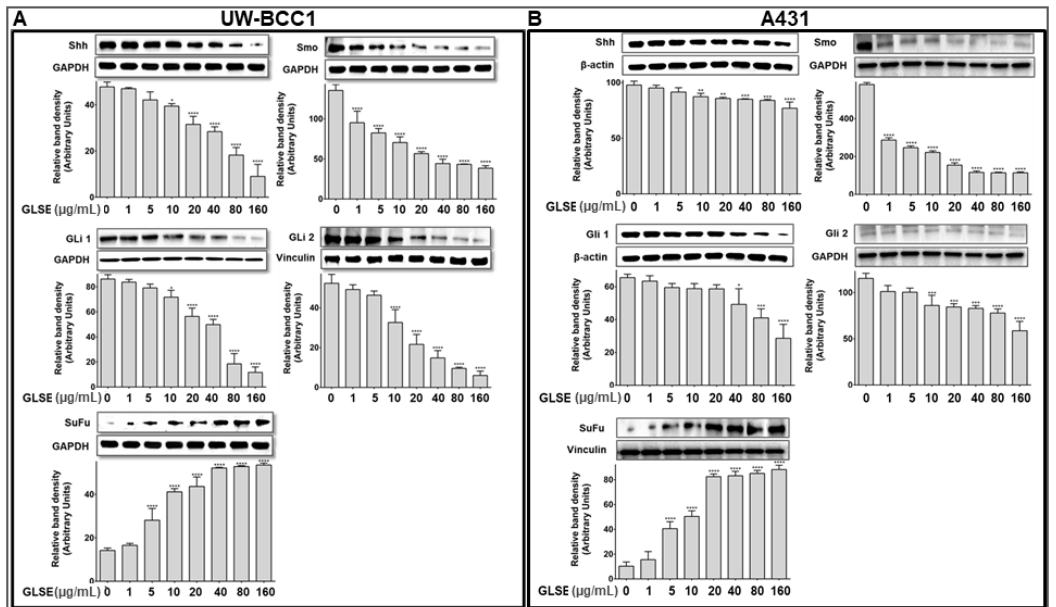
Figure 4. GLSE modulates Hedgehog Signaling Pathway Components in UW-BCC1 and A431 Cells. Whole cell lysates of ( A ) UW-BCC1 and ( B ) A431cells treated with/without GLSE (0–160 µg/mL: 24 h) were subjected to SDS-polyacrylamide gel electrophoresis and blots were probed with antisera to hedgehog pathway proteins Shh, Smo, Gli1, Gli2, and SuFu. Equal loading was confirmed by re-probing with GAPDH, β-Actin, GAPDH and vinculin. The immunoblots shown are representative of three independent experiments, each conducted in duplicate, which all gave similar results. Bars represent the means ± SD. * p < 0.05, ** p < 0.01, *** p < 0.001 and **** p <0.0001 vs. control (DMSO-treated)